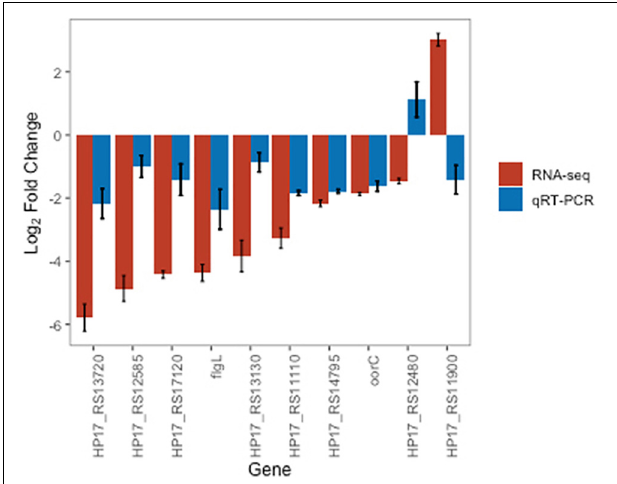
FIGURE 3 | Barplot showing log 2 fold-changes at incubation of 41 ◦ C for 3 days compared to 37 ◦ C using RNA-Seq and qRT-PCR methods for 10 selected DEGs. Error bars indicate standard deviations from the mean. Genes ordered by RNA-Seq log 2